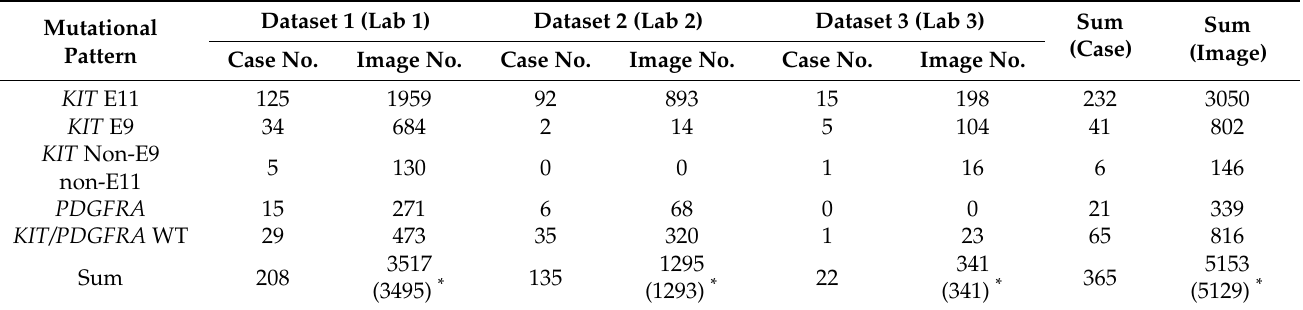
* Real image numbers entering DCNN calculation after excluding images with